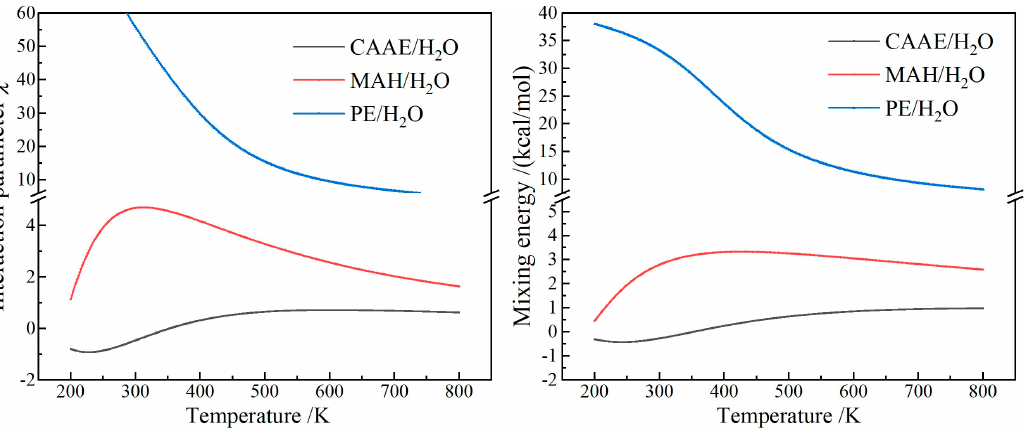
Figure 7. Interaction parameter ( left panel ) and mixing energy ( right panel ) of PE/H 2 O, CAAE/H 2 O and MAH/H 2 O binary molecular mixtures.